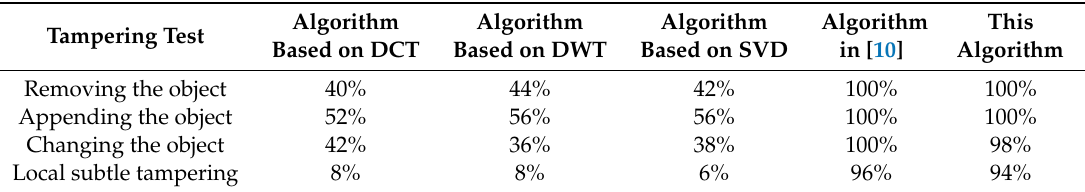
Figure 14. Examples of local subtle tampering: ( a ) Original images, ( b ) corresponding tampered images. Table 3. The comparison of sensitivity to